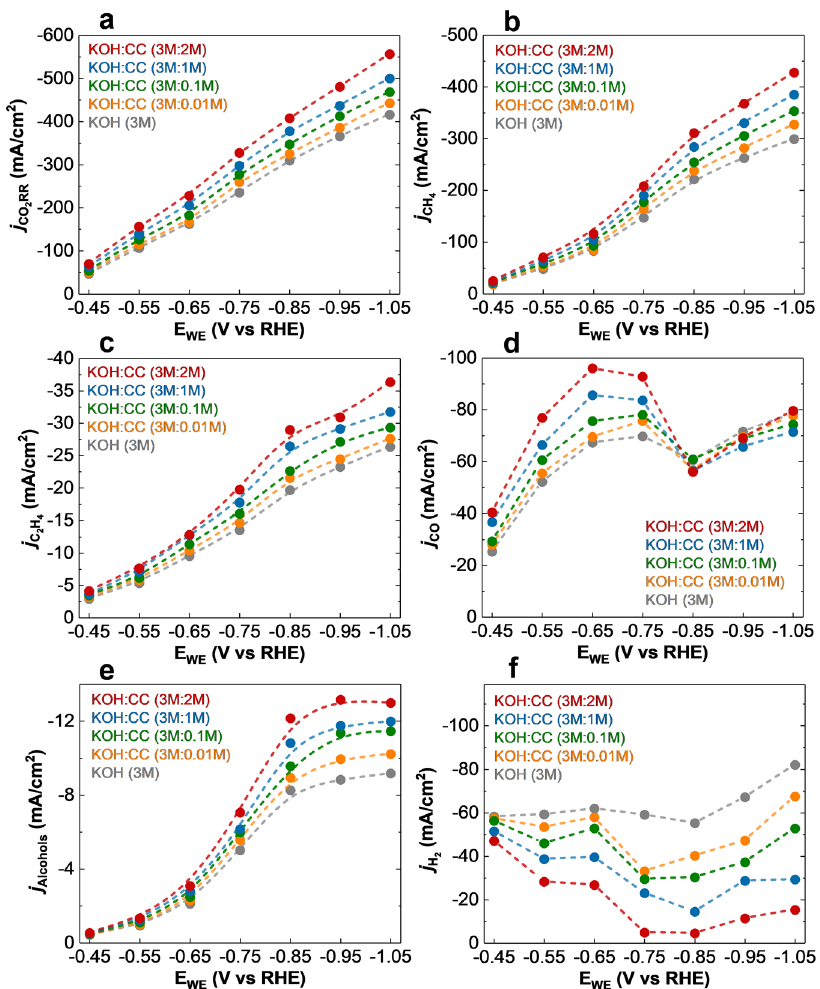
Fig. 4 Effect of choline chloride in the electrochemical performance of W 2 C NFs for CO 2 RR. The values are measured using 3 M KOH and mixed 3 M KOH with different concentrations (0.1, 0.01, 1, and 2 M) of choline chloride (CC) electrolytes. Partial current density ( j ) measurements for a CO 2 RR, b CH 4 , c C 2 H 4 , d CO, e Alcohols (CH 3 OH and C 2 H 5 OH), and f H 2 as a function of potential (E WE